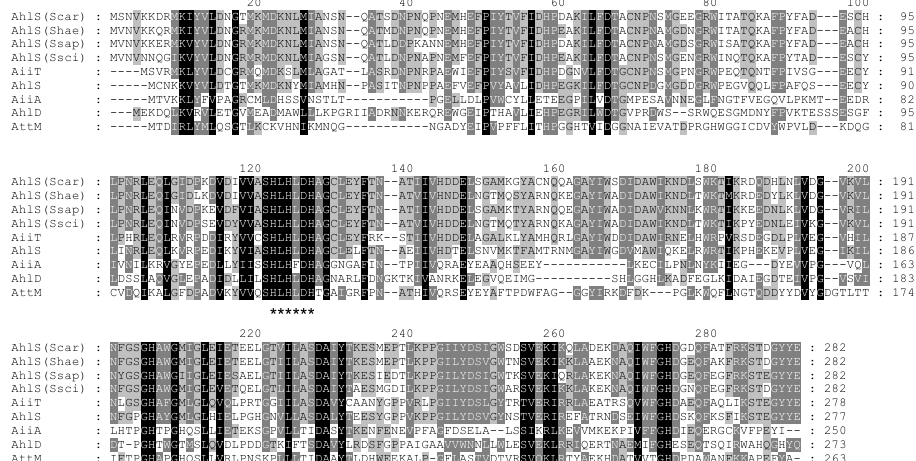
Figure 2. Comparisons of AhlS from the CNS strains with the known AiiA-like AHL lactonases. The amino acid sequences of AhlS from S. carnosus NBRC 109622 (Scar), S. haemolyticus NBRC 109768 (Shae), S. saprophyticus NBRC 102446 (Ssap), and S. sciuri ATCC 29060 (Ssci) were compared to those of the AhlS from Solibacillus silvestris StLB046 (UniProt accession no. F2F233), AiiT from Thermaerobacter marianensis JCM 10246 (E6SI95), AiiA from Bacillus sp. 240B1 (Q9L8R8), AttM from Agrobacterium tumefaciens C58 (Q7D3U0), and Arthrobacter sp. IBN110 (Q7X3T2). Sequences were aligned using ClustalW and shaded using the GeneDoc software. The consensus amino acid sequence (HXHXDH) was marked with